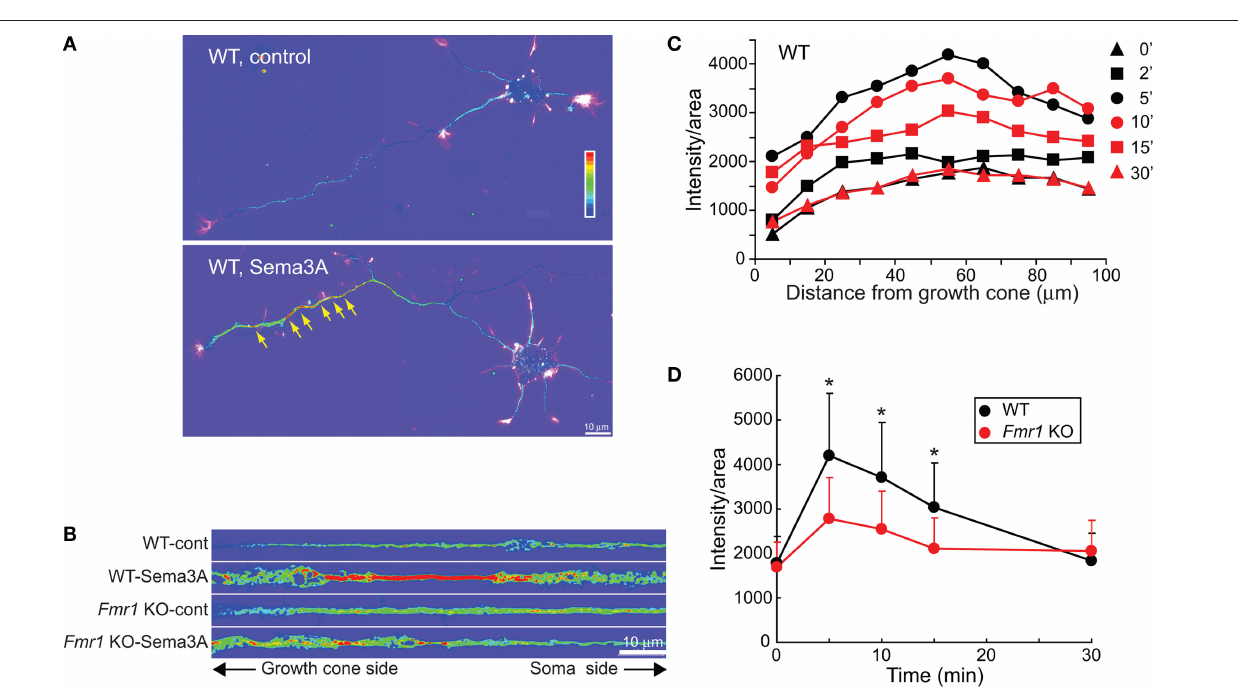
(red). Alexa488-phalloidin staining of F-actin in growth cones is illustrated by white color. (B) Fluorescent intensities of the growth cones (a) and straightened axons (b) in WT neurons and Fmr1 KO neurons treated under the condition as described in (A) . Data are mean ± SEM for n = 10, * p < 0.05. Note that increase in phospho- eIF4E IF by Sema3A in WT is not observed in Fmr1 KO neurons.